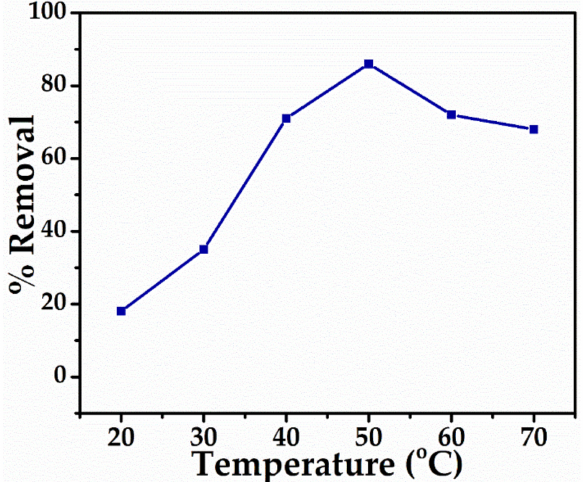
Figure 5. Effect of temperature on the removal of Cr 6+ ions.